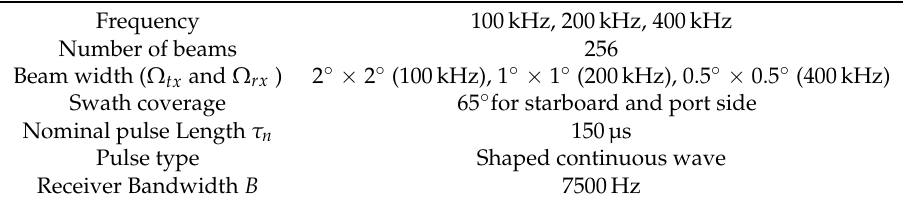
Table 1. Characteristic of R2Sonic 2026 MBES used during